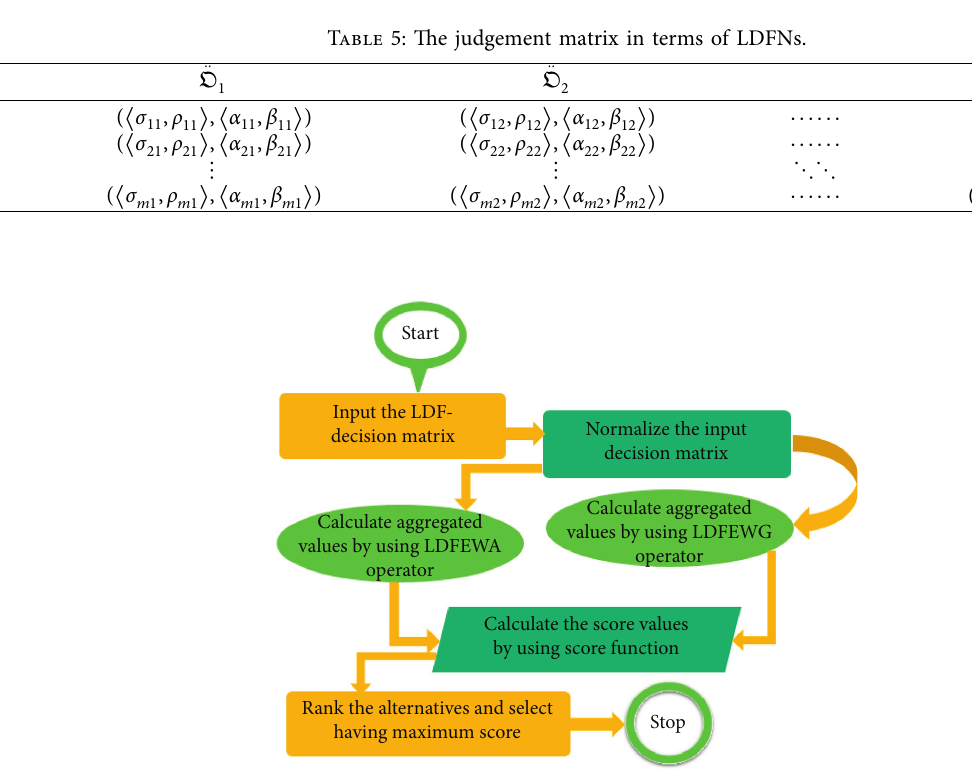
Figure 5: Pictorial view of proposed